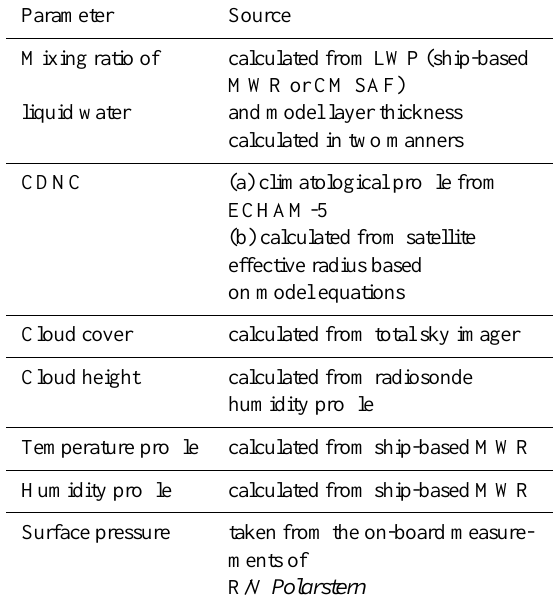
Table 1. Overview of different parameters prescribed in the model. Additionally it is shown, how these parameters are derived and what the dependencies are.